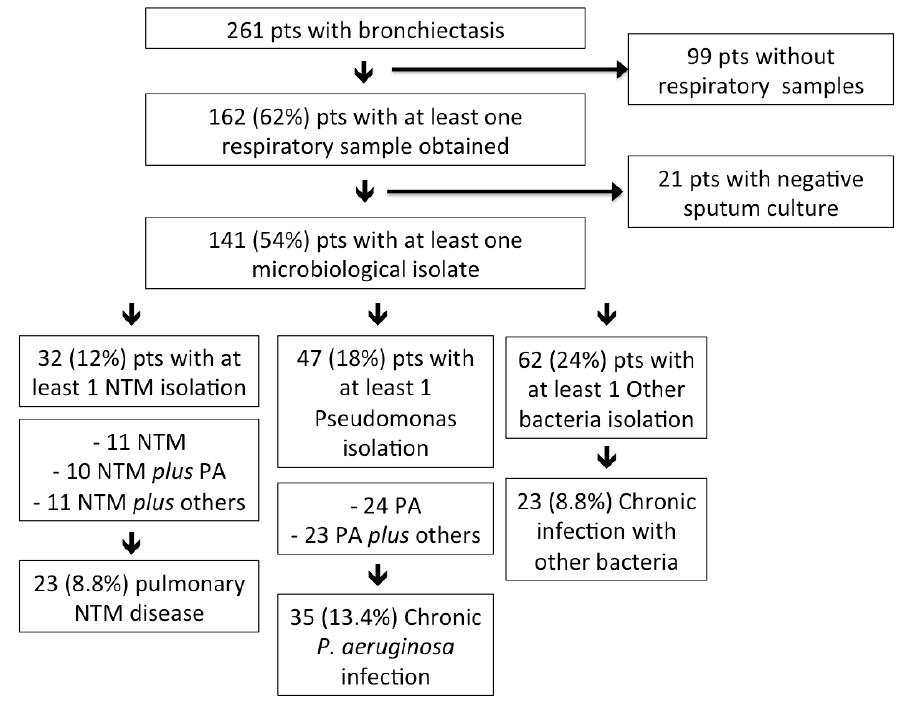
Figure 1. Division of the entire population according to microbiological isolations. PA = P. aeruginosa ; NTM = non-tuberculous mycobacteria; pts = patients. Table 1. Non-tuberculous mycobacteria isolated in the study